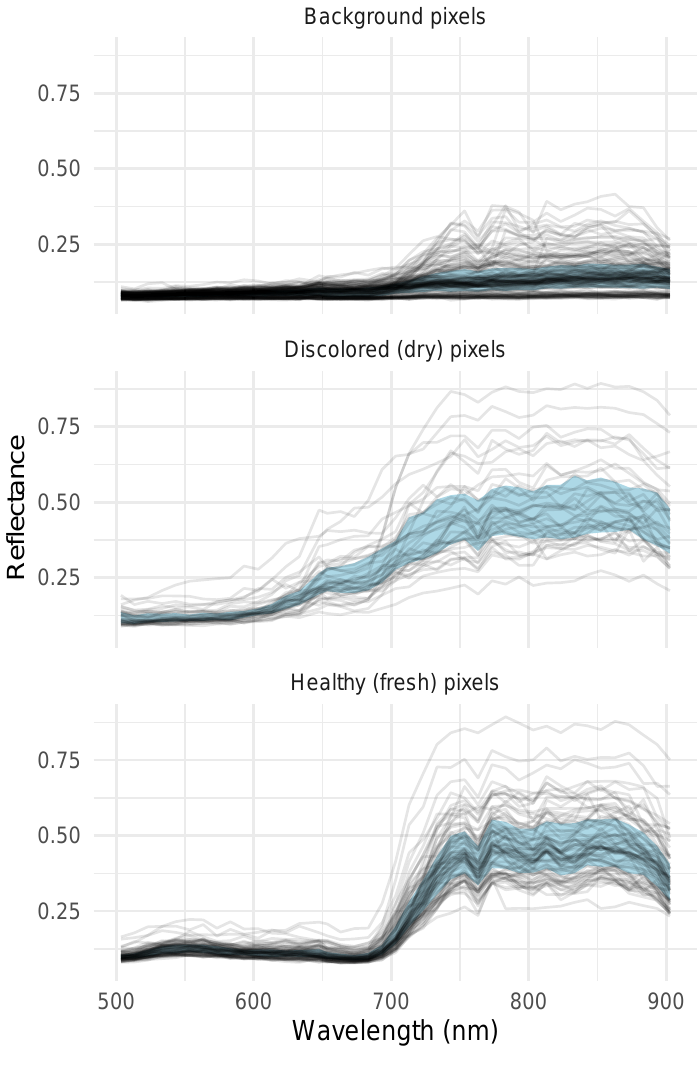
Figure 4. Representative hyperspectra of the pixel classes obtained from SVM segmentation of pot images. The blue areas delimit the interquartile reflectance